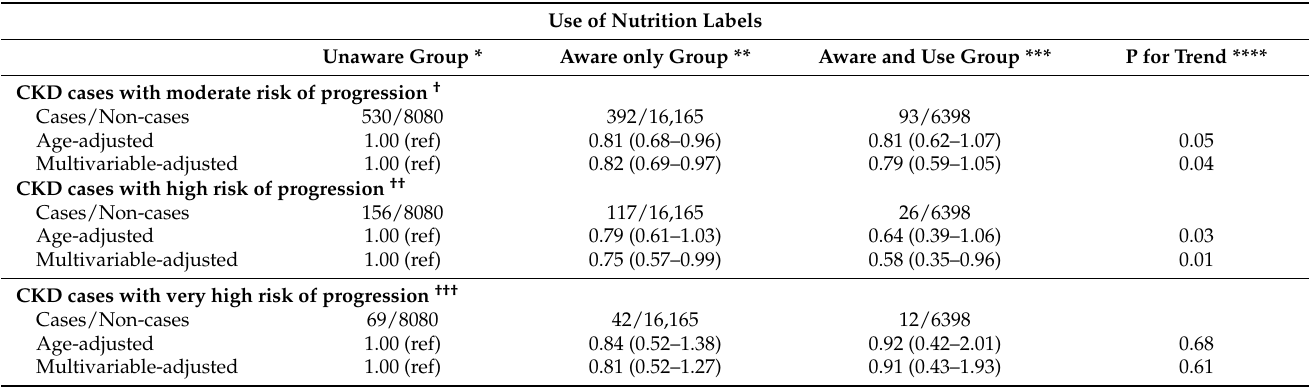
Table 3. Multivariable-adjusted $ odds ratio (95% confidence intervals) of CKD subtypes defined by its risk of progression by use of nutrition labels.